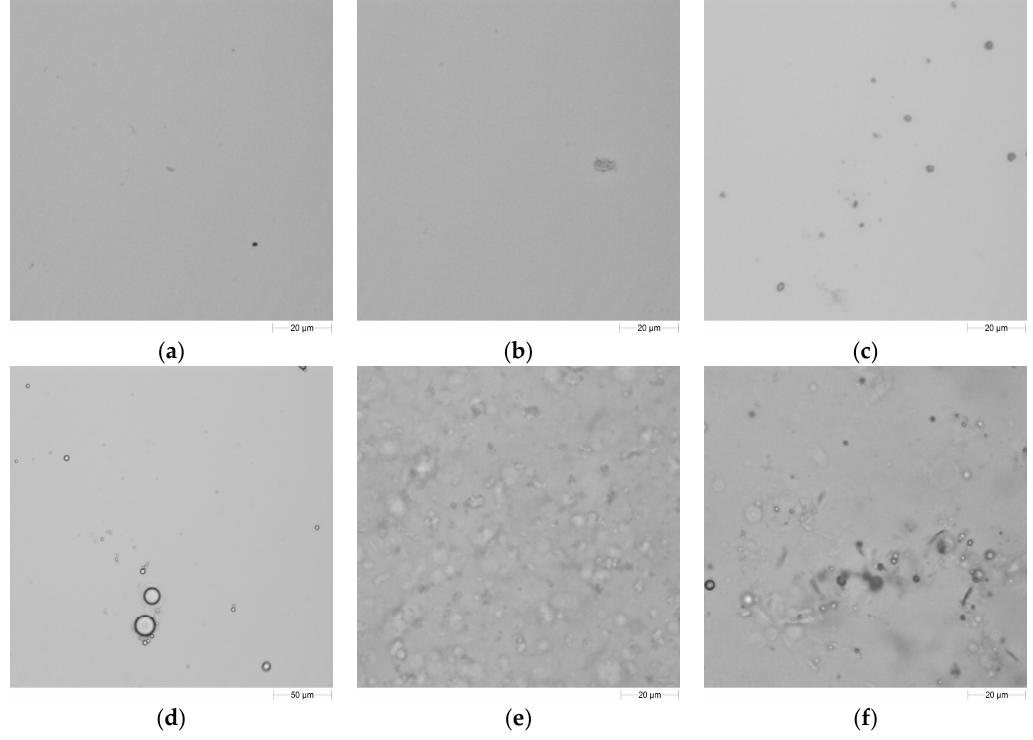
Figure 6. Microscope images of surfactant added coatings: ( a ) 0.25% tween 40; ( b ) 1% tween 40; ( c ) 0.25% span 80; ( d ) 1% span 80; ( e ) 0.25% lecithin; ( f ) 0.25% span 60. Surfactants listed in letters,